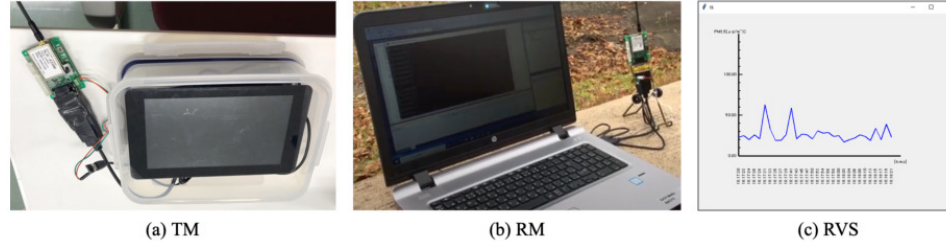
Figure 5. Assembled transmitter module (TM) and receiver module (RM) consisting of LCS.